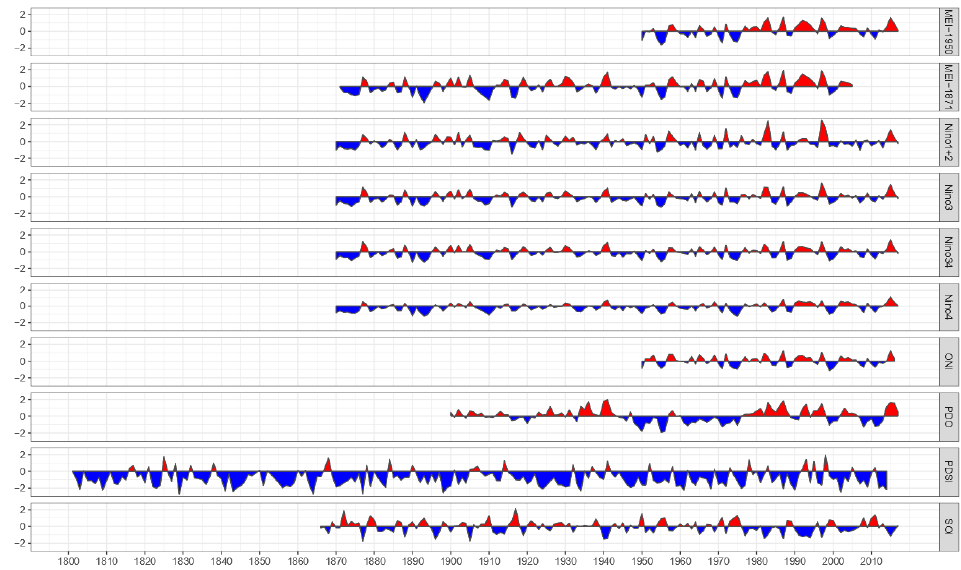
Figure 7. Time series of PDO, ENSO indices (source: https://www.esrl.noaa.gov/psd/data/climateindices/list) and PDSI. MEI-1871 and MEI-1950 are the Multivariate ENSO Index series starting in 1871 and 1950 simultaneously; indices Niño1+2, Niño3, Niño34 and Niño4 are the mean Sea Surface Temperature anomalies in the Pacific Ocean regions: 0–10 S, 90 W–80 W; 5 N–5 S, 150 W–90 W; 5 N–5 S, 170–120 W; 5 N–5 S, 160 E–150 W, respectively; ONI is the Oceanic Niño Index; PDO is the Pacific Decadal Oscillation; SOI is the Southern Oscillation Index.